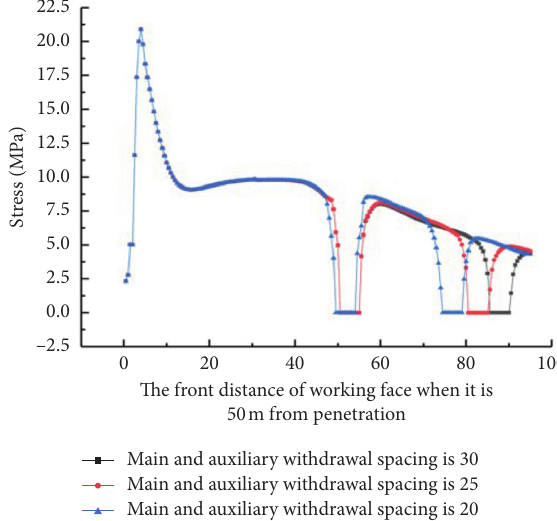
Figure 10: Vertical stress curve when Panel 31113 is 50m from penetration.